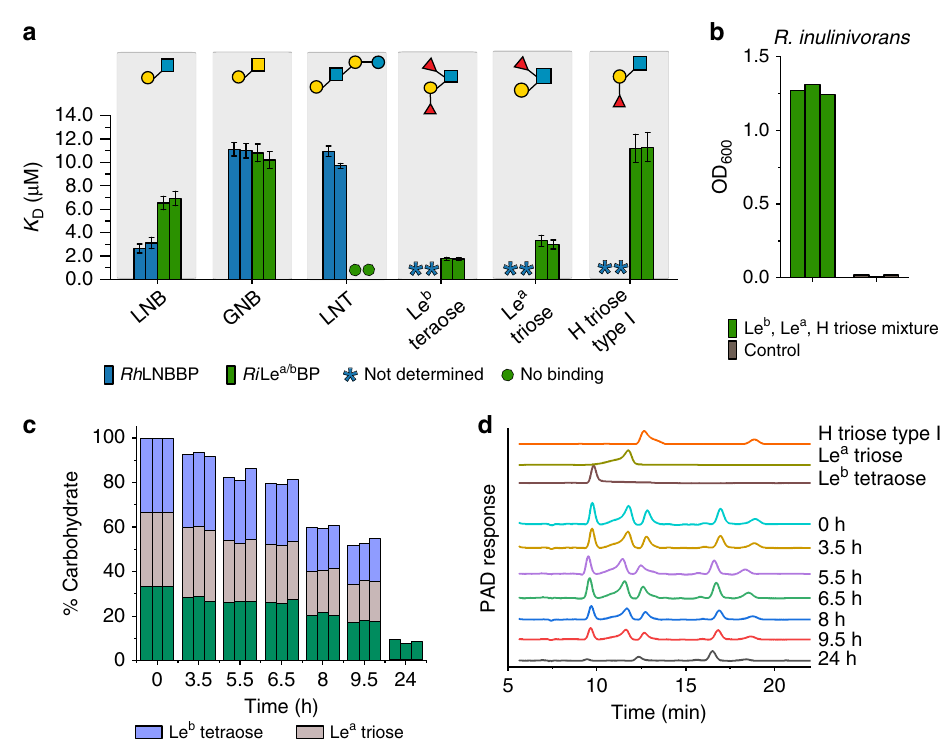
Fig. 4 Roseburia transport proteins mediate capture of HMOs and related host derived oligosaccharides. a Binding analysis of HMOs and host derived oligosaccharides to Rh LNBBP and Ri Le a/b BP. b , c Growth and uptake preference of R. inulinivorans on an equimolar mixture of Le b tetraose, Le a triose and